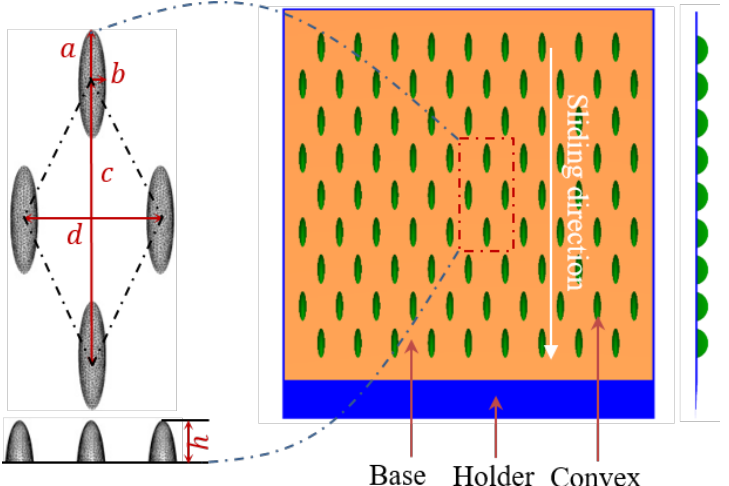
Figure 8. Meshed convex pattern sample (a: major radius; b: minor radius; c: vertical distance; d: horizontal distance; h: height of convex) [7].